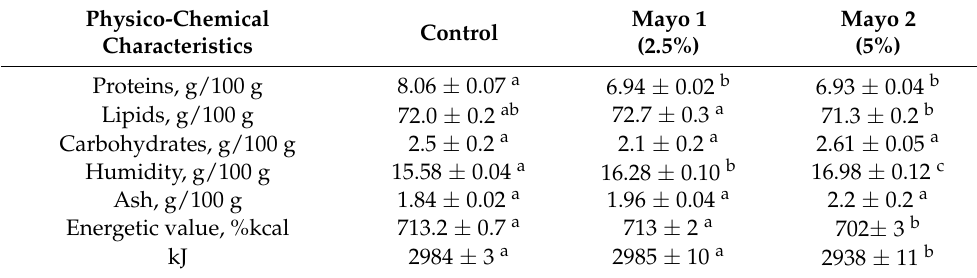
Table 5. Physico-chemical characteristics of value-added mayonnaise. Physico-Chemical Characteristics